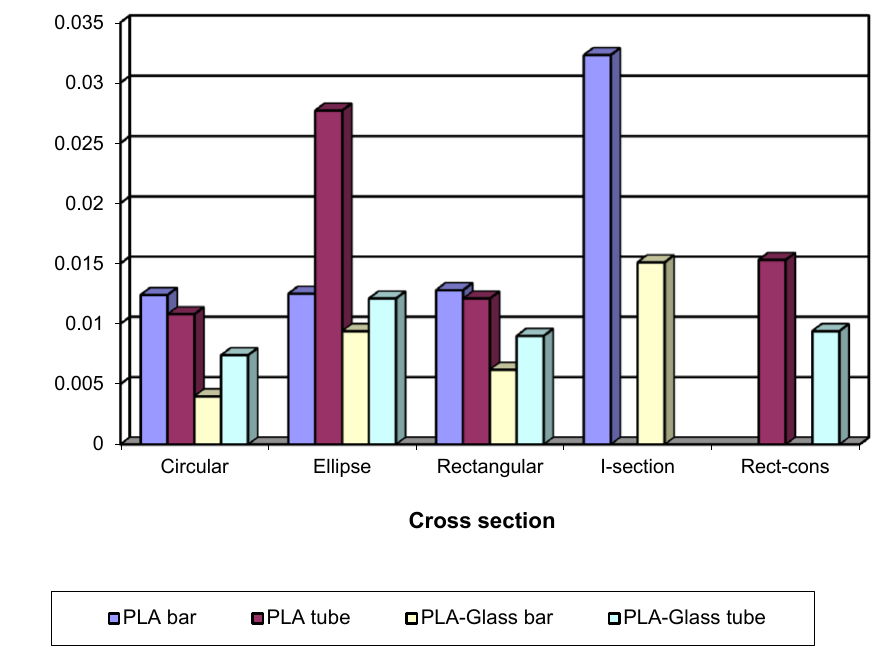
Figure 9. Efficiency of section